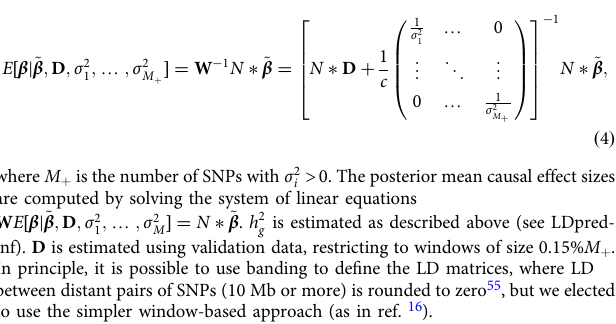
ffiffiffiffiffiffiffiffiffiffiffiffiffiffiffiffiffi 2 (cid:3) p i (cid:3)ð 1 (cid:2) p i Þ